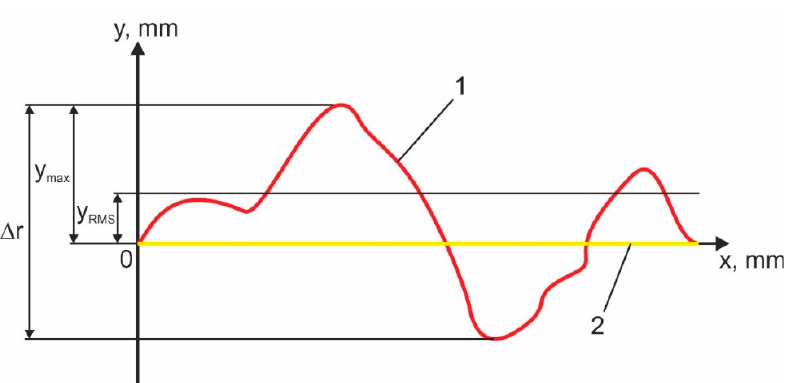
Figure 4. The scheme of indicators to evaluate the trajectories, with (1) trajectory of effector and (2) reference trajectory.